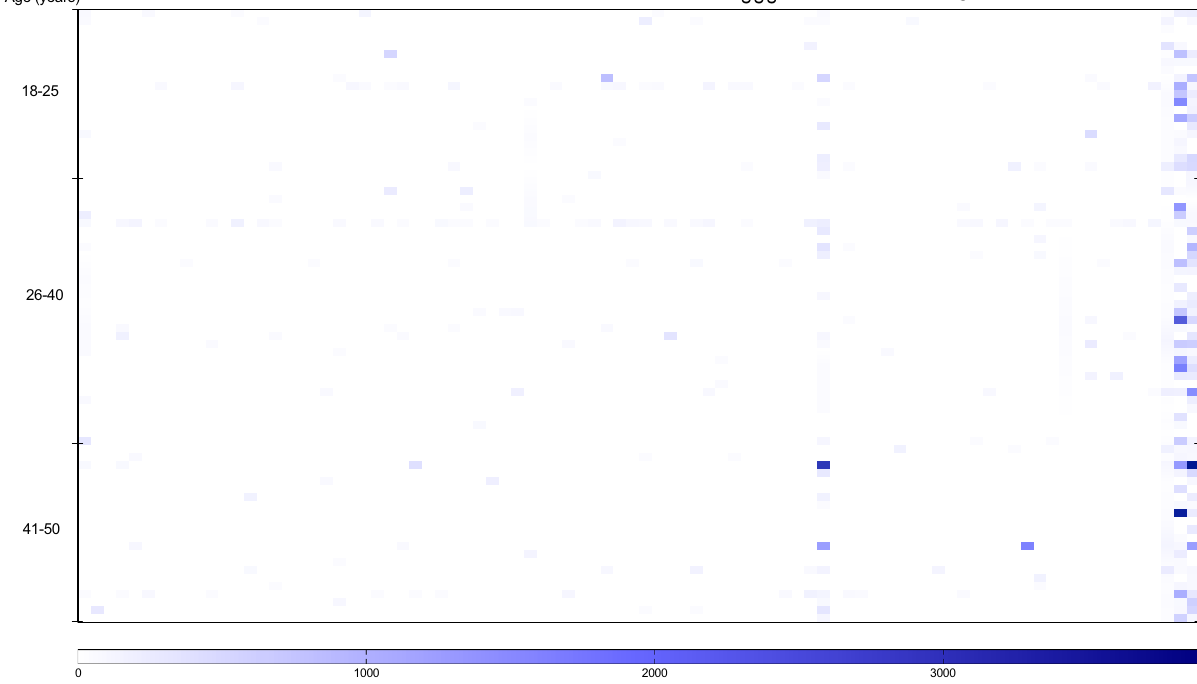
Fig. 2 KSHV-speci fi c IFN- γ responses of 76 Ugandans aged 18 – 50 years. Ex vivo ELISpot assay was used to determine IFN- γ responses to KSHV overlapping peptide pools. Spot forming cells (SFCs) per million PBMCs were recorded for each reaction. The intensity of the purple colour correlates with the number of SFCs per million PBMCs. The raw data used to draw this graph are shown in Supplementary Data 1. SIV Simian immunode fi ciency virus, EBV Epstein – Barr virus, CEF CMV + EBV + fl u cocktail. Heatmap drawn in GraphPad Prism version 8.0.1. Source data are provided as a Source Data fi le.